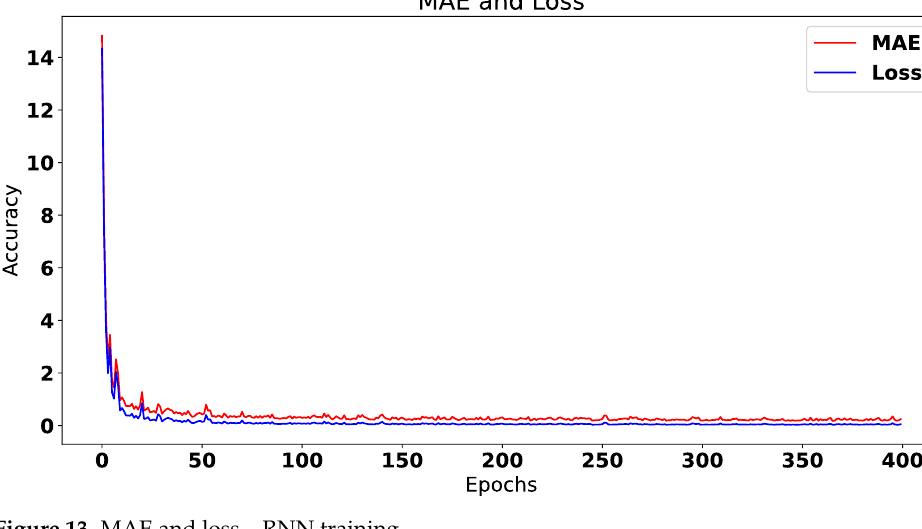
Figure 13. MAE and loss—RNN training.